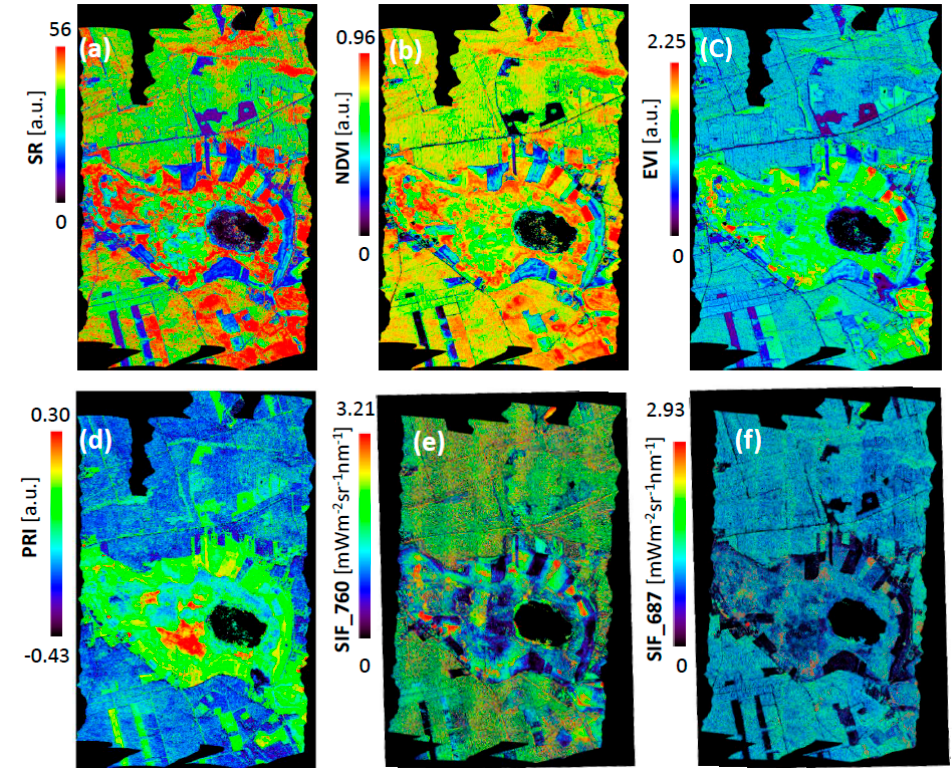
Figure 4. Airborne maps of the different vegetation indices from the experimental site, derived from DUAL module (370–2500 nm) of the HyPlant with a spatial resolution of 1 m × 1 m per pixel. The data was recorded on 11 July 2015, and was acquired during the afternoon overpasses of HyPlant. ( a ) Simple Ratio (SR), ( b ) Normalized Difference Vegetation Index (NDVI), ( c ) Enhanced Vegetation Index (EVI), ( d ) Photochemical Reflectance Index (PRI), ( e ) SIF map for O 2 A (760 nm), and ( f ) SIF map for O 2 B (687 nm). The associated range of each of the vegetation indices and SIF maps is represented in color stretch on the left.